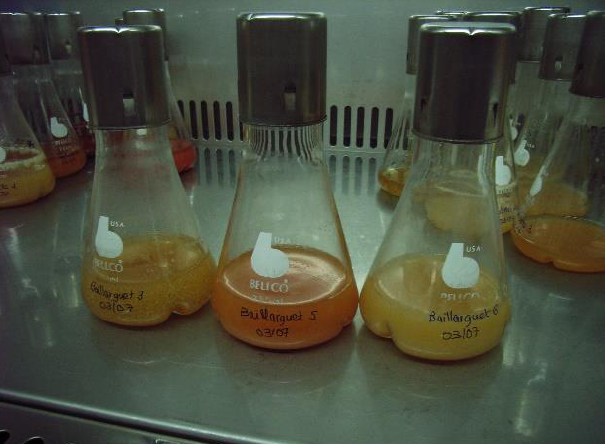
Figure 3. Fungal isolates in liquid cultures recovered from a Lasioptera donacis ’ fungal community sampled at Baillarguet in France. The three isolates belong to three different MOTUs.